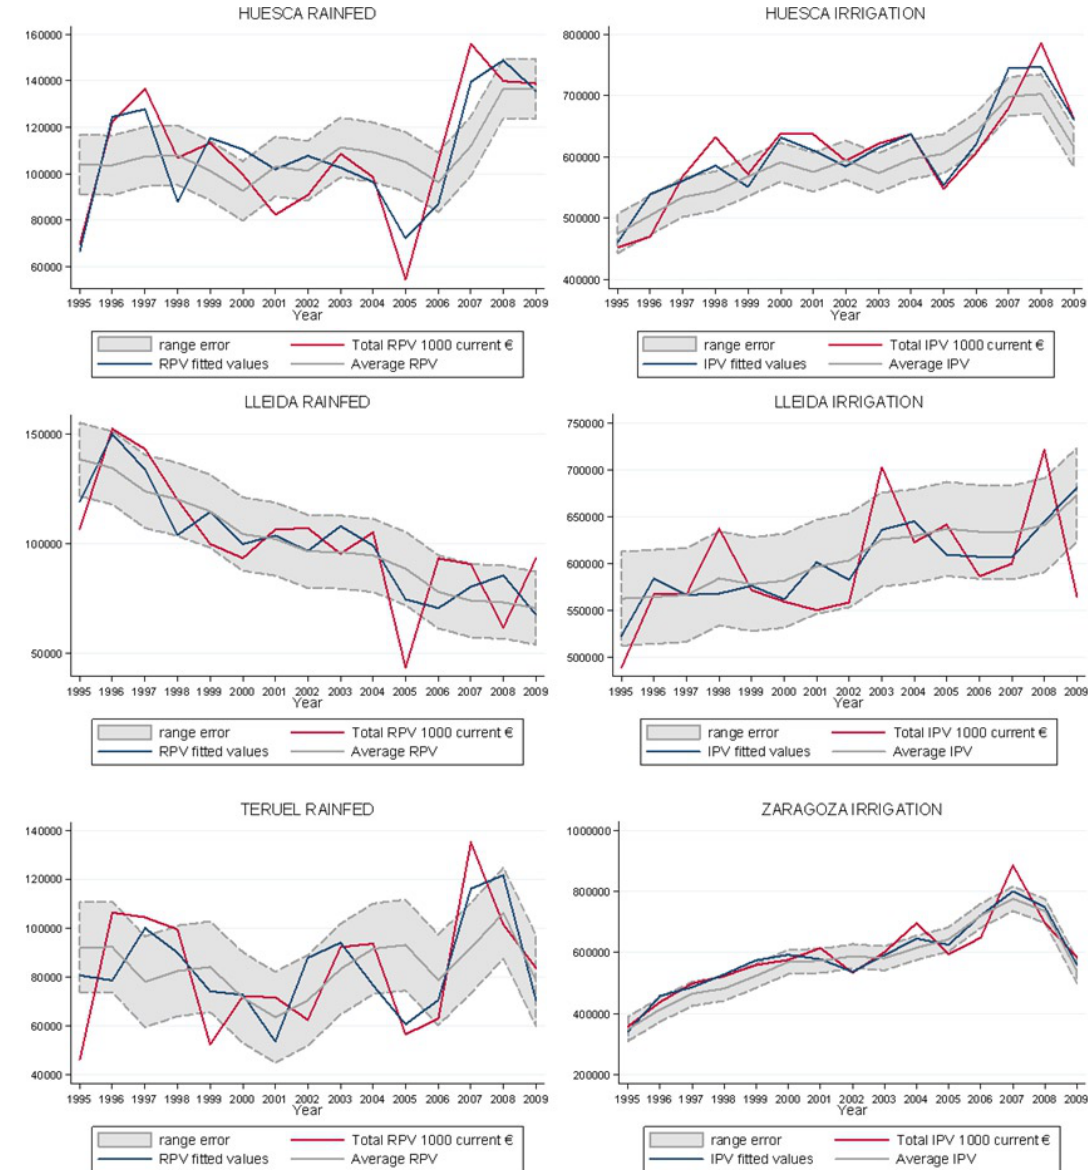
Fig. 2. Production values of rainfed and irrigated agriculture (thousand of current C) in the provinces of Huesca, Lleida and Teruel (1995– 2009). Observed data, predicted value, average values and confident intervals. Source: authors’